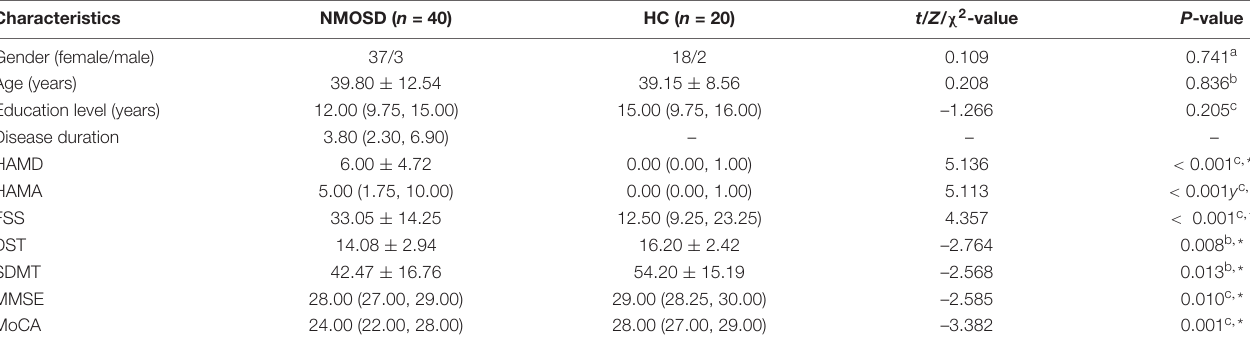
TABLE 2 | Demographic data and neuropsychological scales of